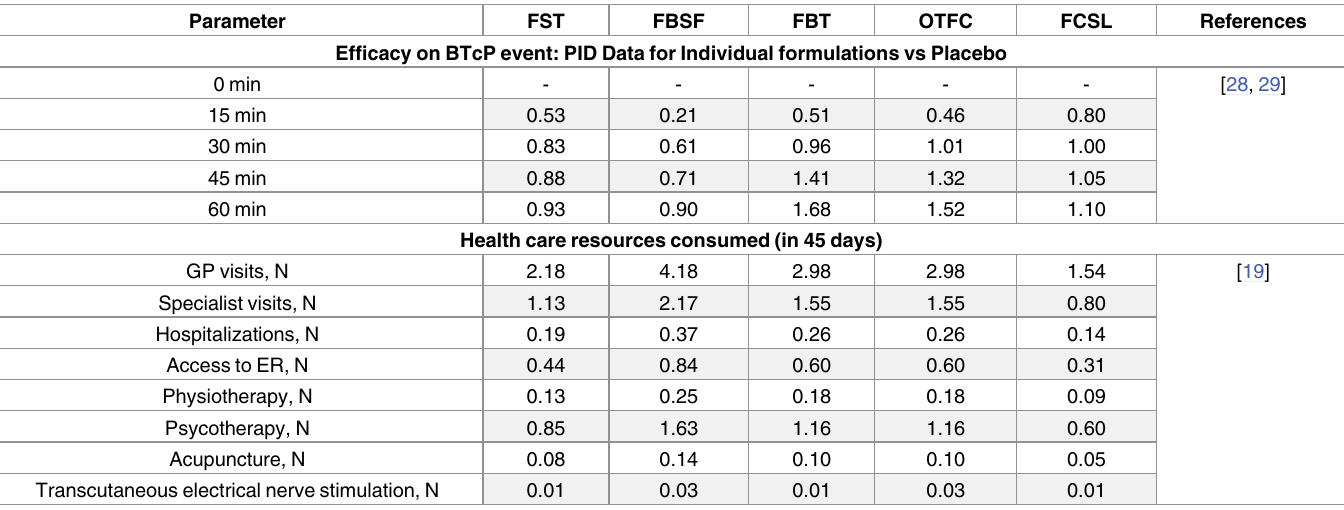
Table 2. Treatment efficacyand health care resources consumed by each fentanyl formulation.